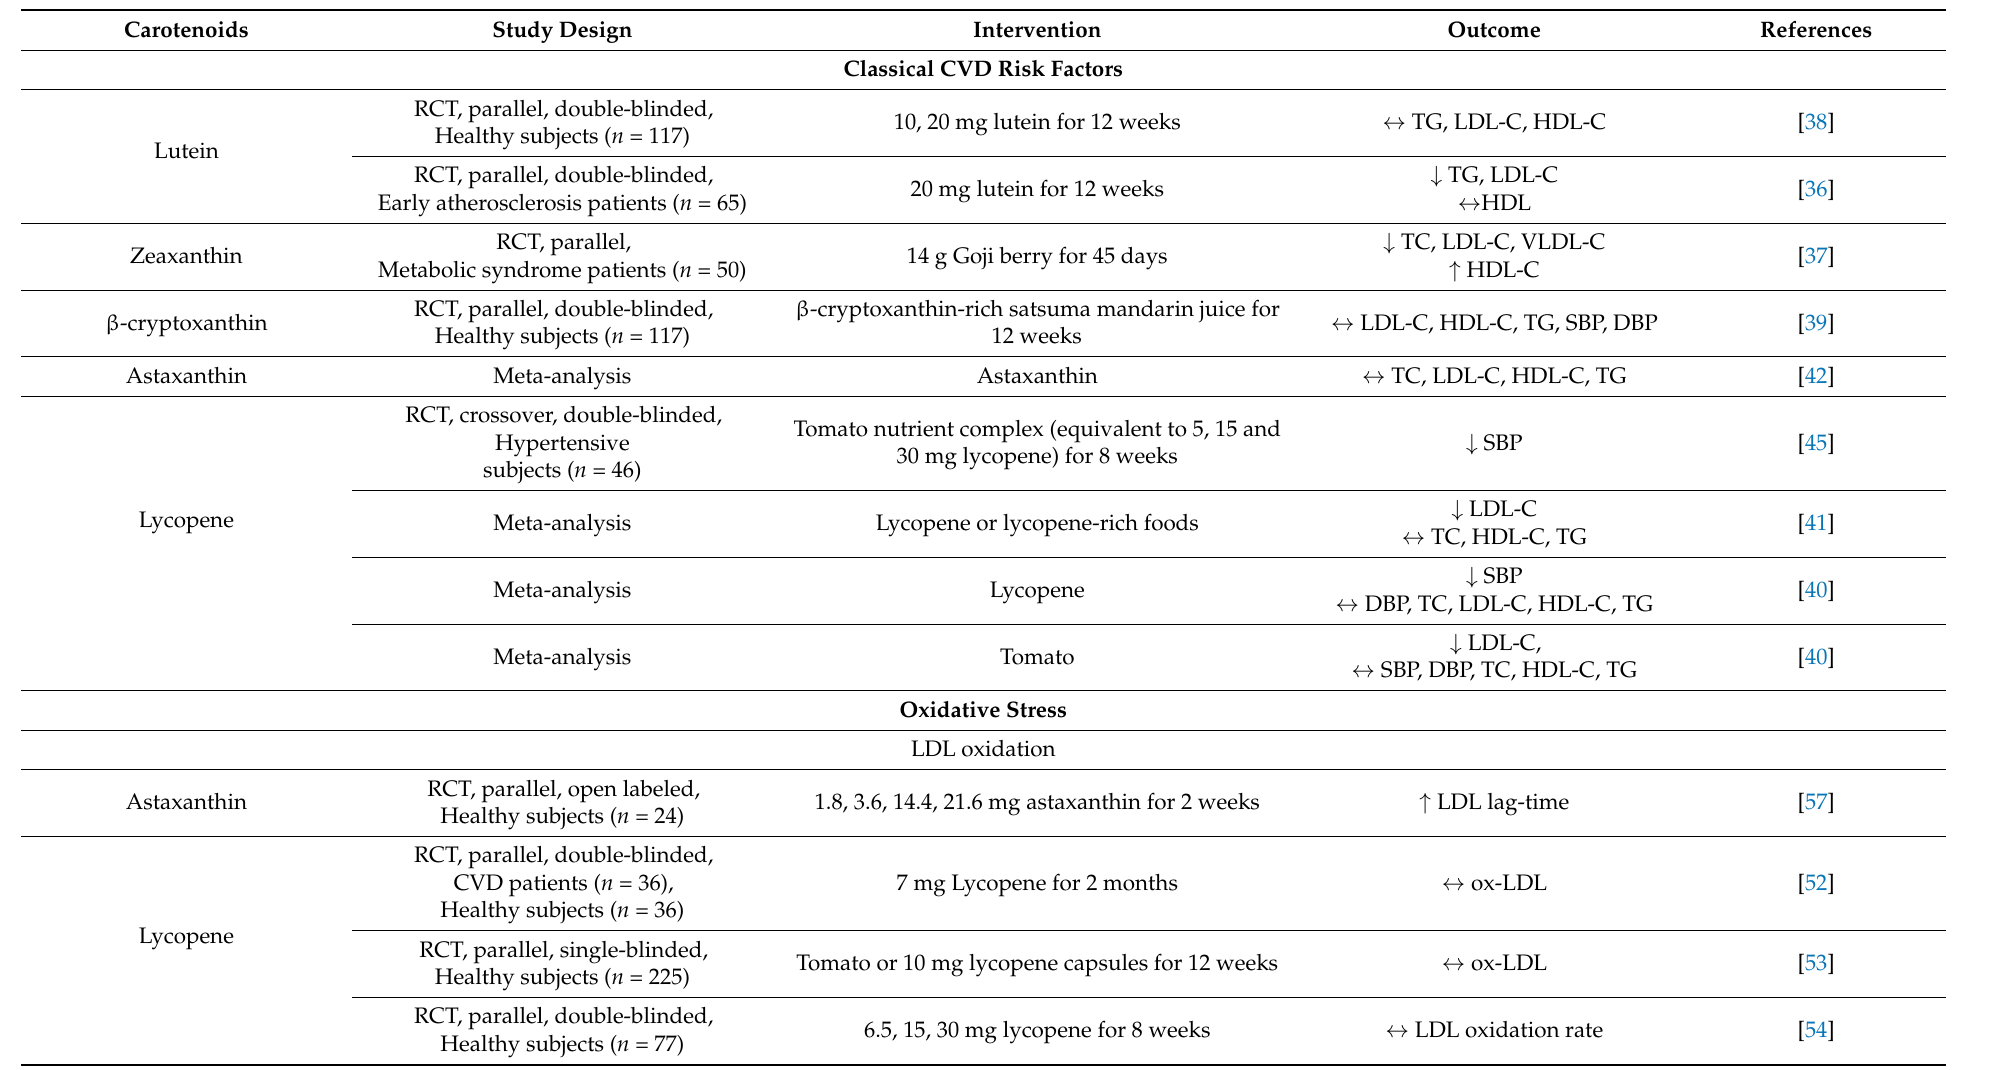
Table 2. Evidence of the effects of carotenoids on CVD health from randomized controlled